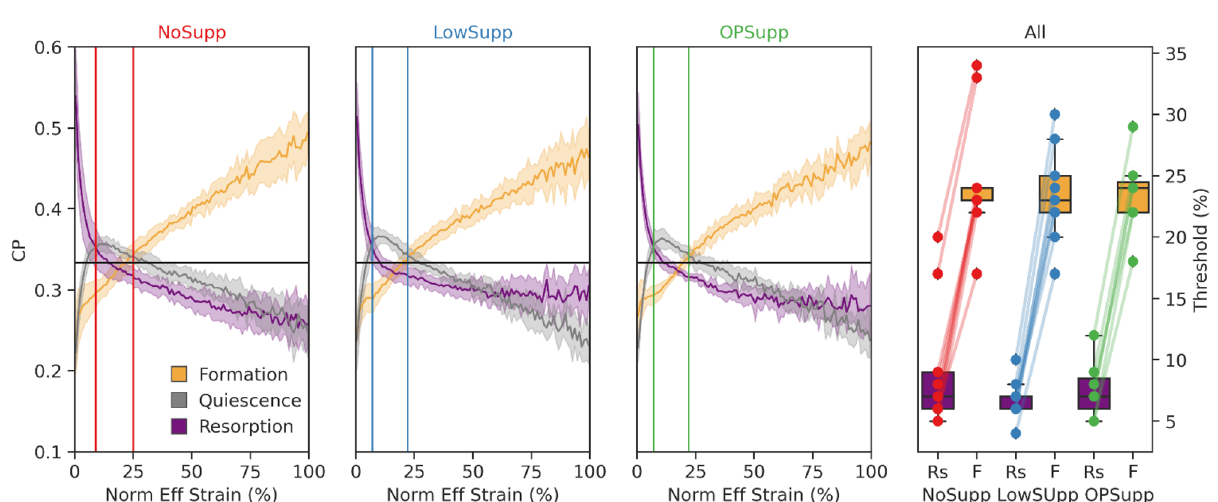
Figure 3. The conditional remodeling probability (CP) of remodeling sites relative to the mechanical environment, quantified as effective (Eff) strain from a simulated 1% compression, for NoSupp, LowSupp, and OPSupp groups. Normalized Eff strain distributions were used to calculate the CP for events of formation (shown in orange), quiescence (shown in grey), and resorption (shown in purple) to occur at distinct strain levels. Average thresholds dividing strains associated with resorption dominant (Rs) and formation dominant (F) probabilities each group are indicated by the left and right vertical lines, respectively, for NoSupp, LowSupp, and OPSupp (left three plots). Group and patient specific Rs and F thresholds confirmed links between bone formation at high and resorption at low mechanical signals